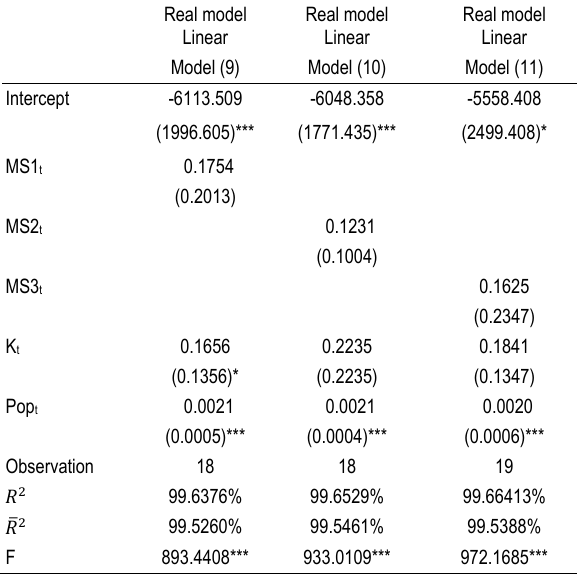
Table 5. The effect of money supply on output